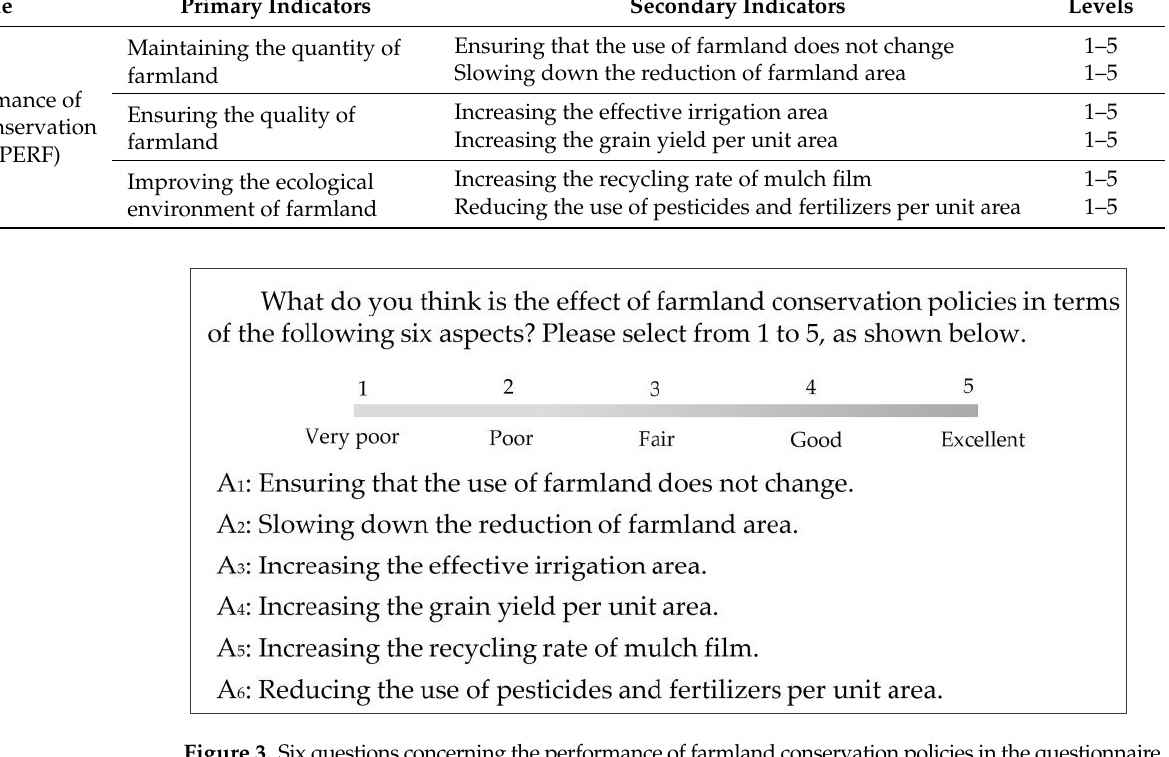
Figure 3. Six questions concerning the performance of farmland conservation policies in the ques- tionnaire.